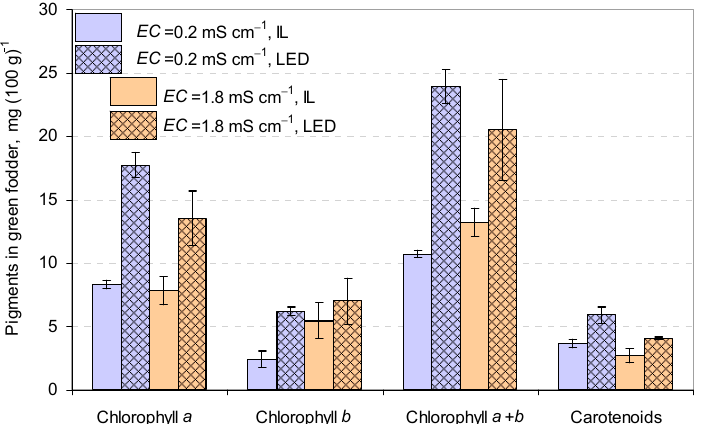
Figure 9. Variation in mass gain of fodder during growing period using LED lighting. Each vertical bar is 95% confidence interval.